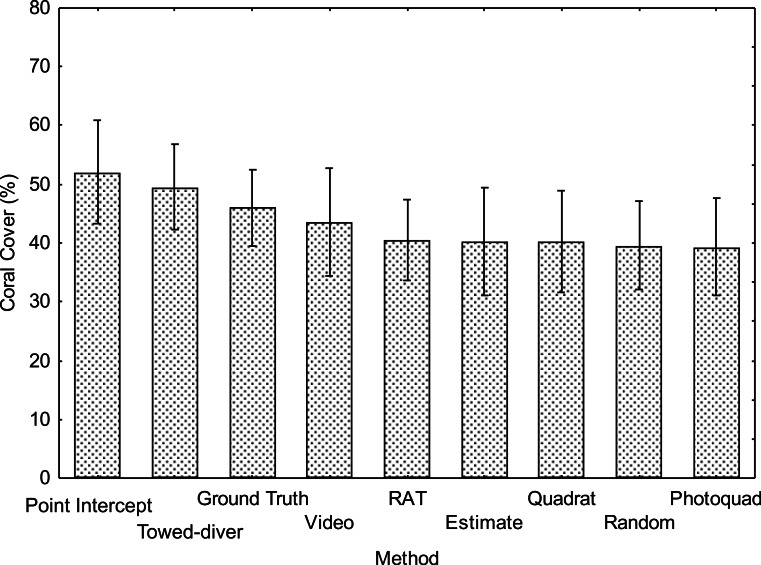
Mean coral cover for the 10 sites as measured by each of 9 methods (±S.D.) Mean number ± 1SE.No significant differences among methods were detected using a Tukey HSD post-hoc test on arcsin-square root transformed data (F8,81 = 0.38 p = 0.93).